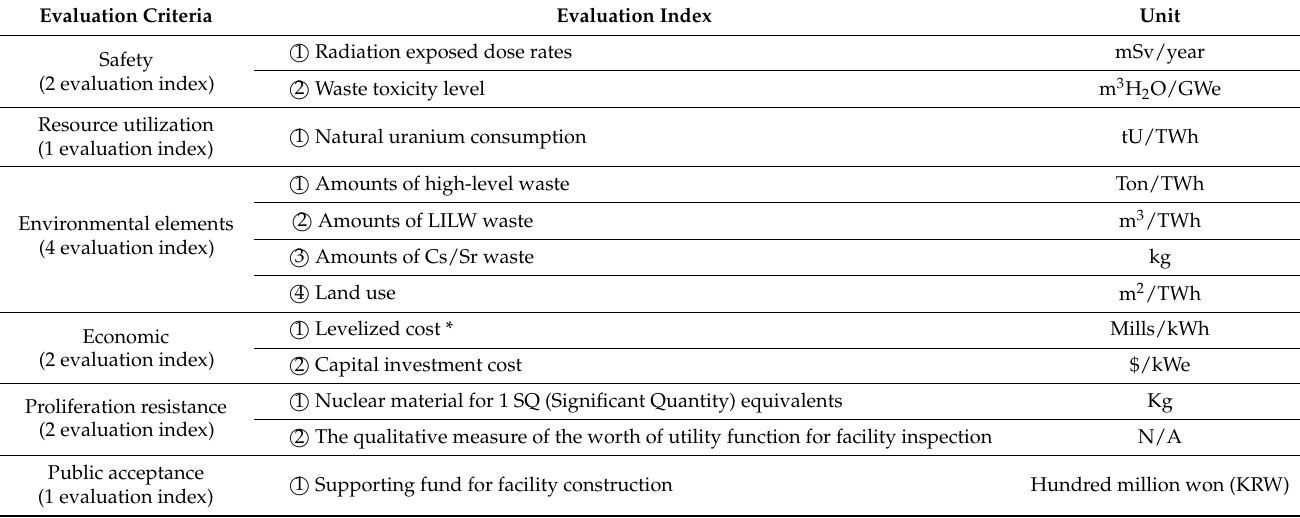
Table 2. Evaluation criteria and evaluation